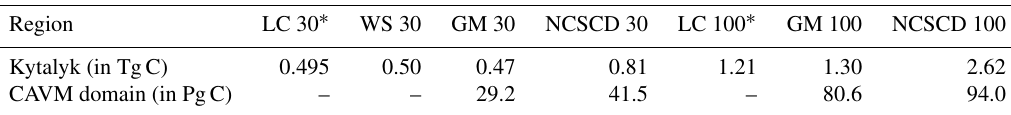
Table 3. Total SOC values (30 and 100cm as indicated) derived from the different data sources: LC – land cover; WS – Wide Swath; GM – Global Monitoring mode; and NCSCD